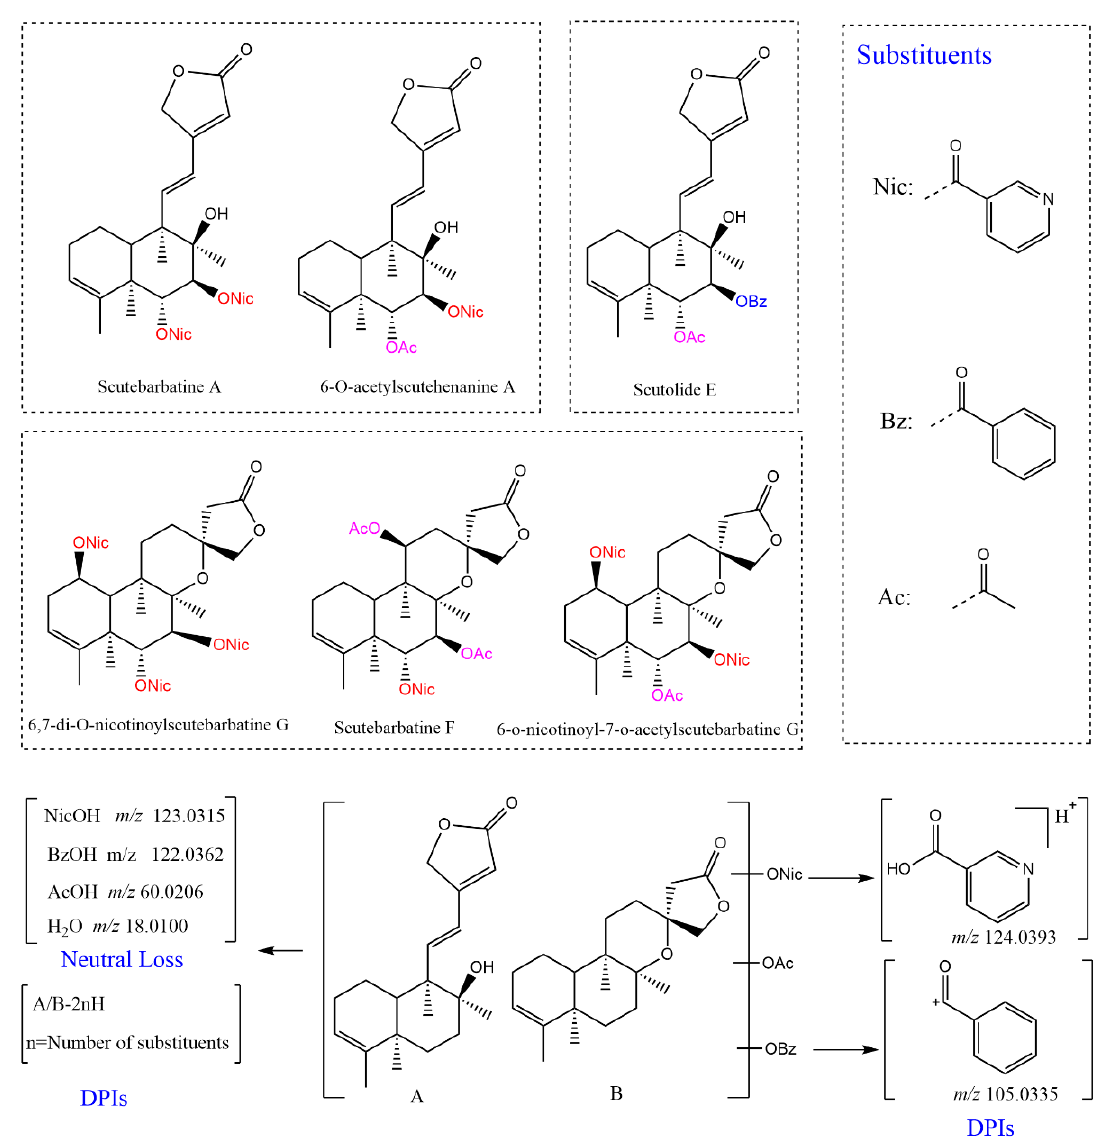
Figure 1. Chemical structures and fragment information of six reference substances under the positive ion mode.